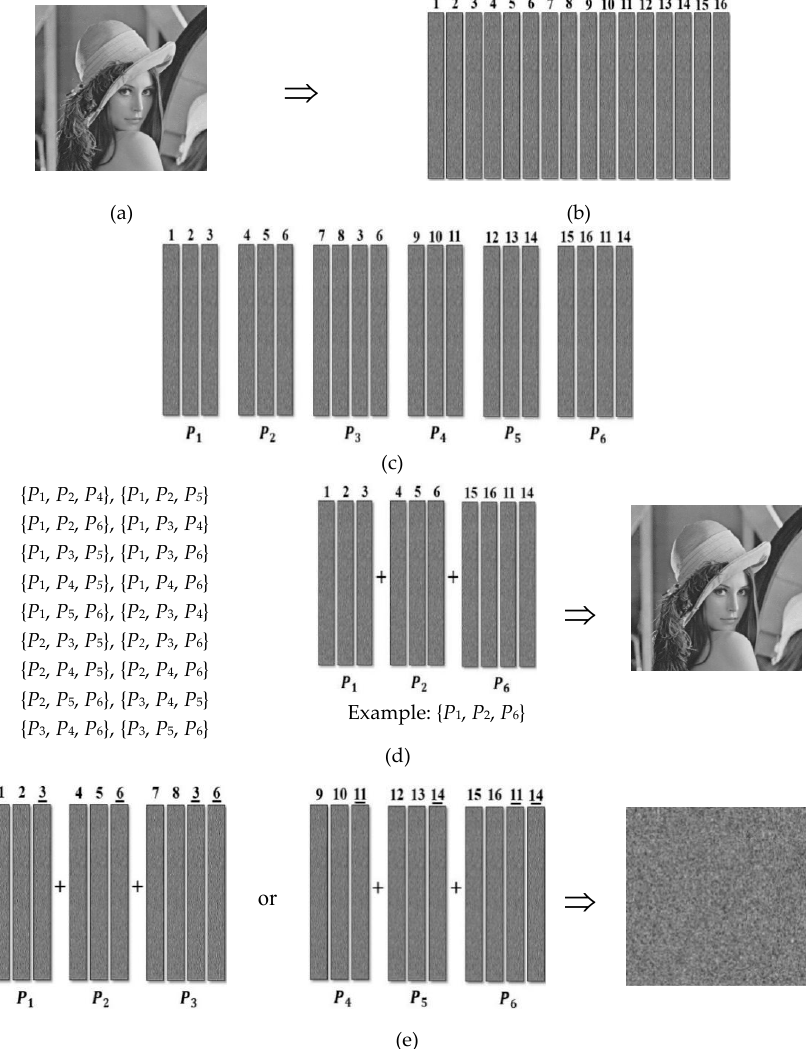
Figure 1. Sharing and decryption experiment of Example 2, which is a ( t participants = 3, n participants = 6, f = 2) example with 2 forbidden combinations. ( a ) is original image; ( b ) uses ( t artificial , n artificial ) = (9, 16) in traditional sharing to share ( a ) and create 16 shares; ( c ) creates 6 shadows for the 6 participants P 1 to P 6 by assigning the 16 shares in ( b ) to them; ( d ) shows that each of the 18 combinations can reveal the secret. Here, the combination { P 1 , P 2 , P 6 } is used as example; ( e ) shows that the 2 forbidden combinations cannot reveal the secret because each combination gets less than 9